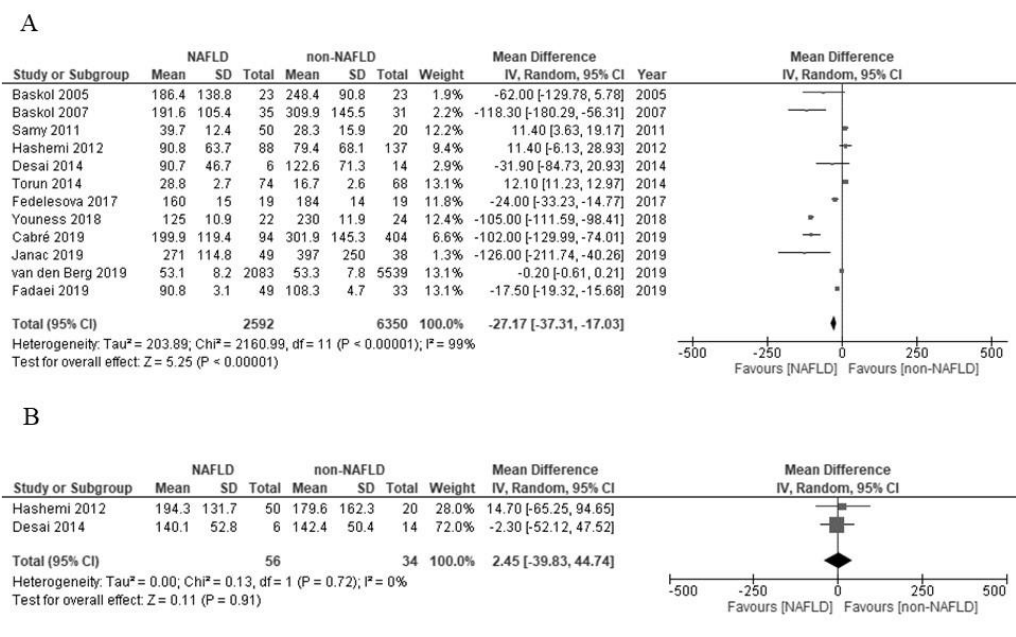
Figure 2. ( A ) Forest plot of the paraoxonase activity and nonalcoholic fatty liver disease. ( B ) Forest plot of the arylesterase activity and nonalcoholic fatty liver disease.